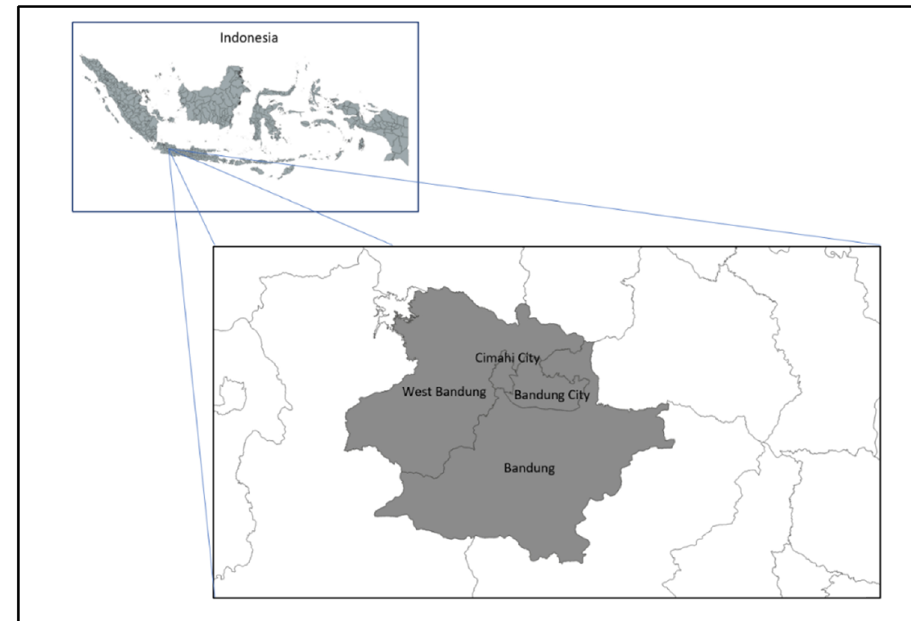
Figure 1: Location of the study.